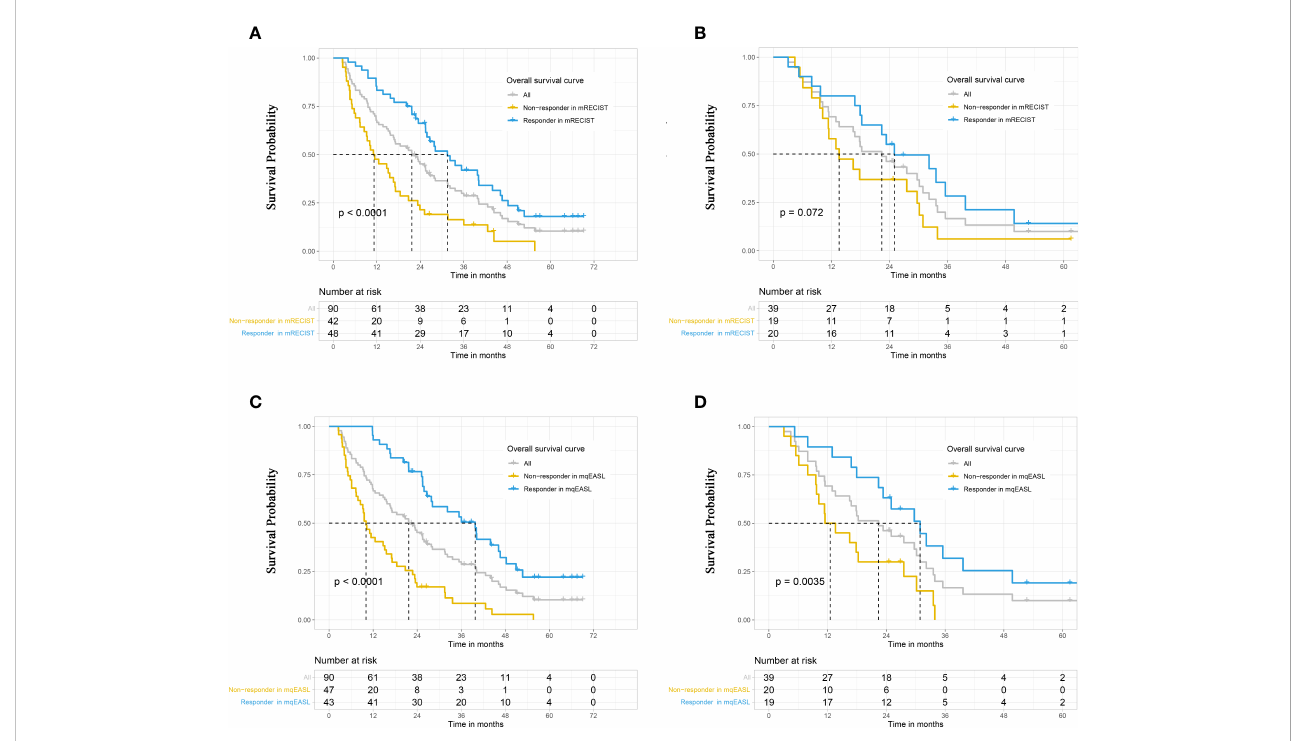
FIGURE 4 Kaplan – Meier curves to compare survival between different groups in the training cohort (A, B) and validation cohort (C, D) . Responders and non- responders were strati fi ed after initial TACE according to tumor response, which was evaluated by the methods of mRECIST (A, C) and mqEASL (B, D) . The result of the log-rank test (p-value) is marked on each graph. mRECIST, modi fi ed Response Evaluation Criteria in Solid Tumors; mqEASL, modi fi ed quantitative European Association for Study of the